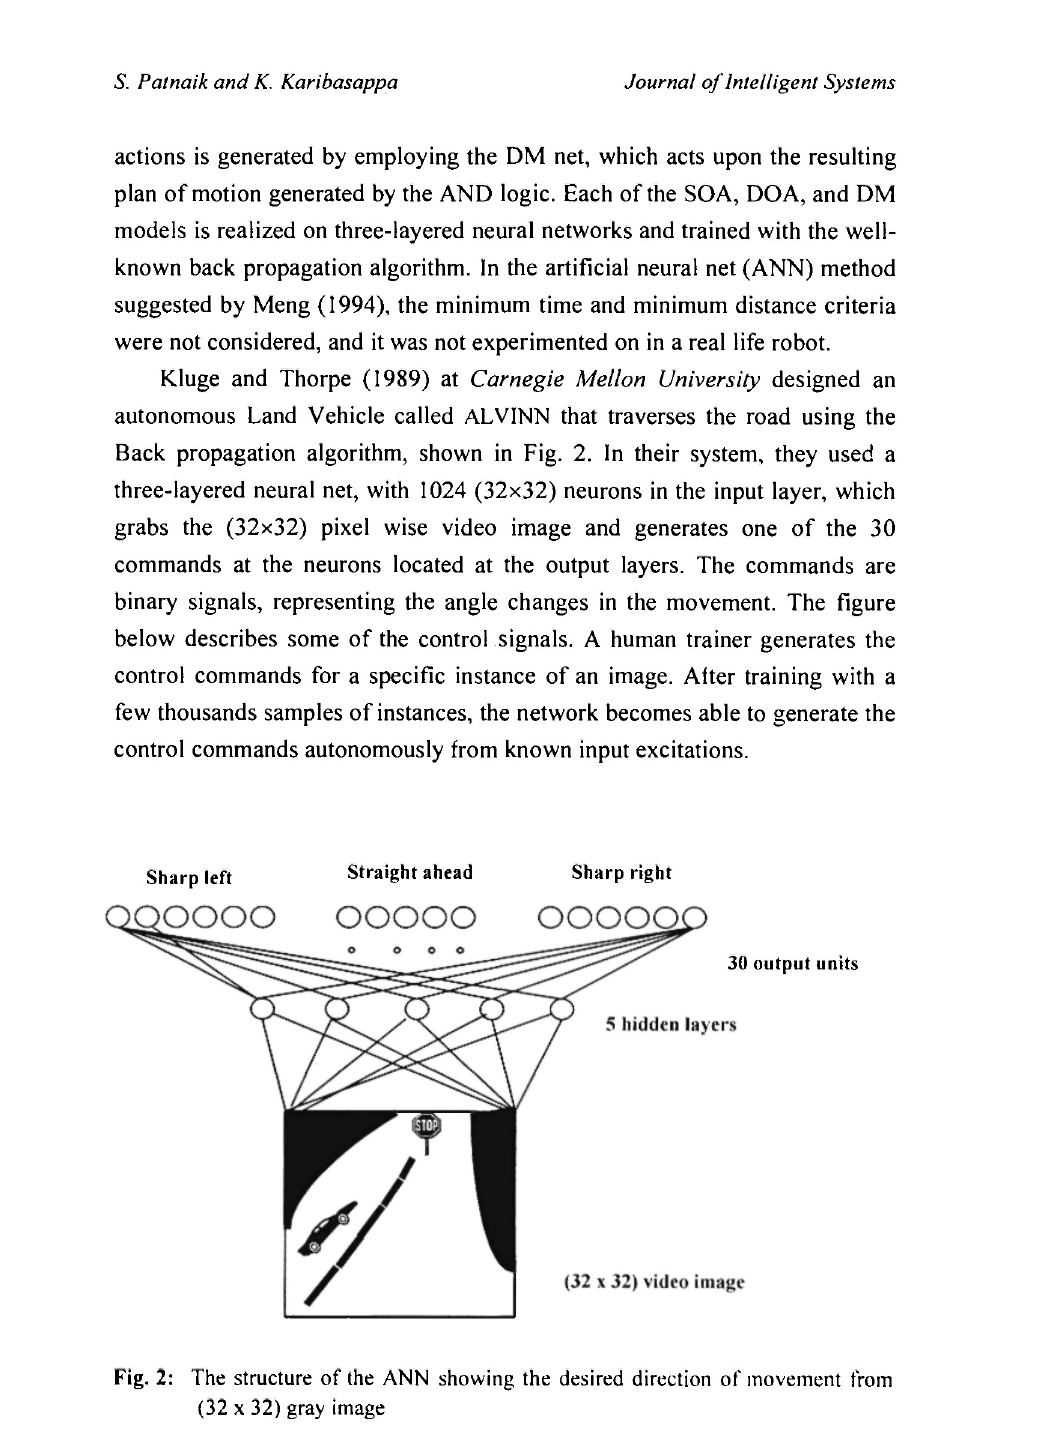
Fig. 2: The structure of the ANN showing the desired direction of movement from (32 χ 32) gray